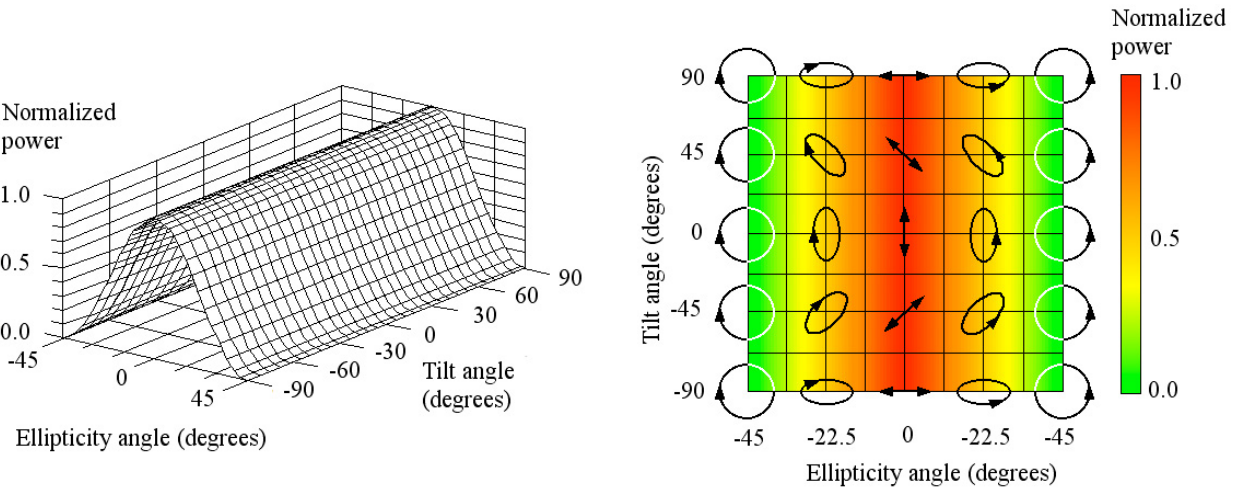
Figure 14. Three-dimensional polarimetric signature of co-polarization channel for a plate and sphere ( left ), and the corresponding two-dimensional visualization ( right